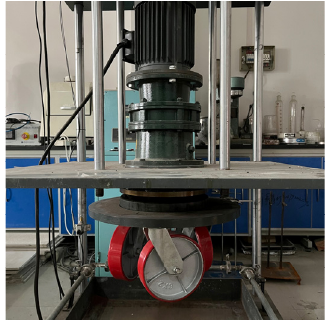
Figure 1. Three − wheel wear device. Figure 1. Three-wheel wear device.